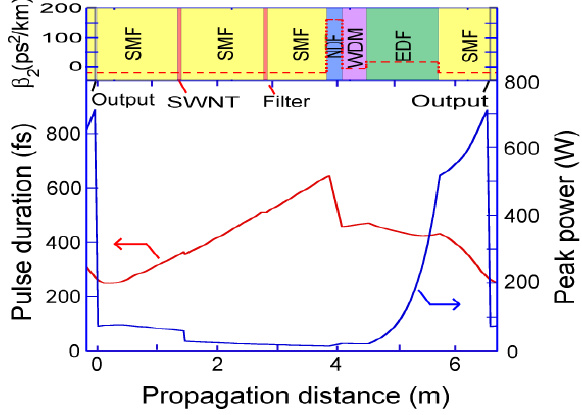
Figure 6. Dynamics of pulse propagation inside the fiber laser cavity for soliton mode-locking